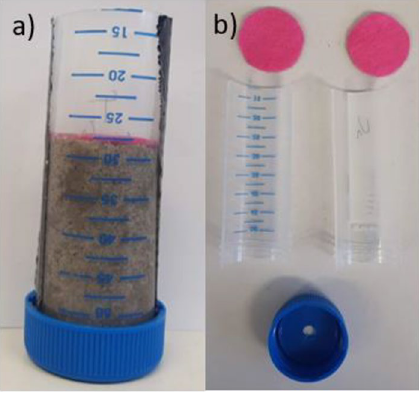
Fig. 1 a packed mould for the MICP b components of the mould before assembly